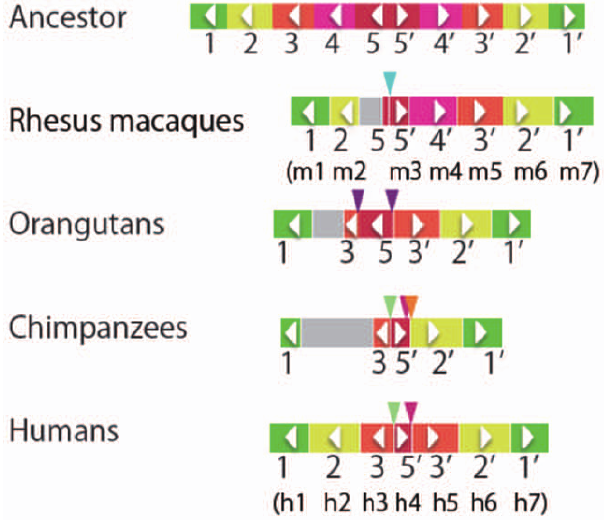
Figure 9. Inferred rearrangements in primate MAGE-A genomic subregion B. A schematic diagram of duplicated units containing MAGE-A genes in an ancestral and extant species is shown. Each colored box indicates a different duplicated unit as in Fig. 5 A . Gray bars indicate sequencing gaps. Colored triangles indicate independent deletions. The same colored triangle in chimpanzees and humans indicates that the deletion occurred in an ancestral species. An arrowhead in each rectangle indicatte the direction of the fragment.